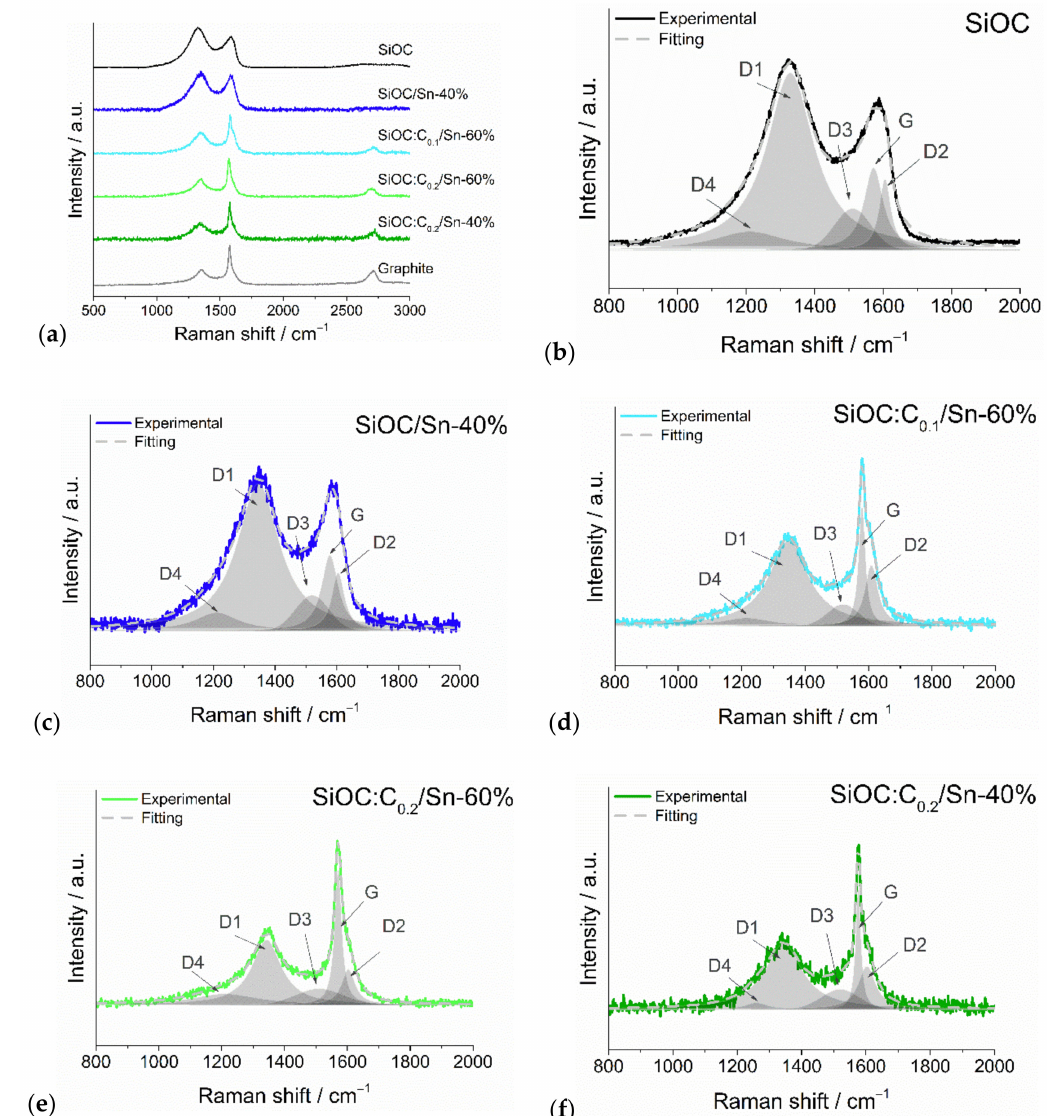
Figure 1. ( a ) Raman spectra of SiOC, graphite and composite materials after background subtraction with custom settings, fitting results for ( b ) pure SiOC, ( c ) SiOC/Sn-40%, ( d ) SiOC:C 0.1 /Sn-60%, ( e ) SiOC:C 0.2 /Sn-60%, and ( f ) SiOC:C 0.2